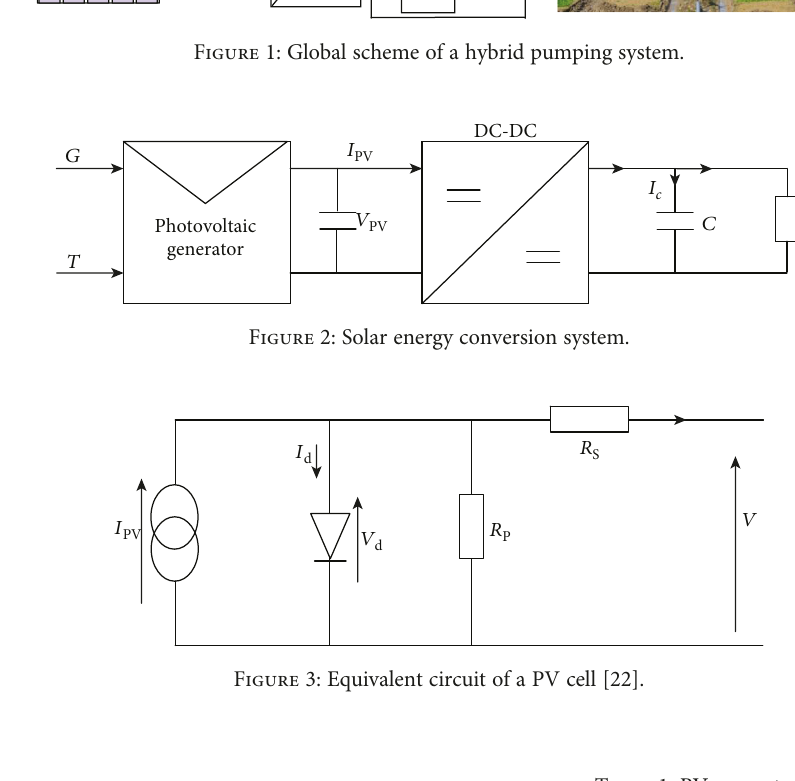
Table 1: PV generator speci fi